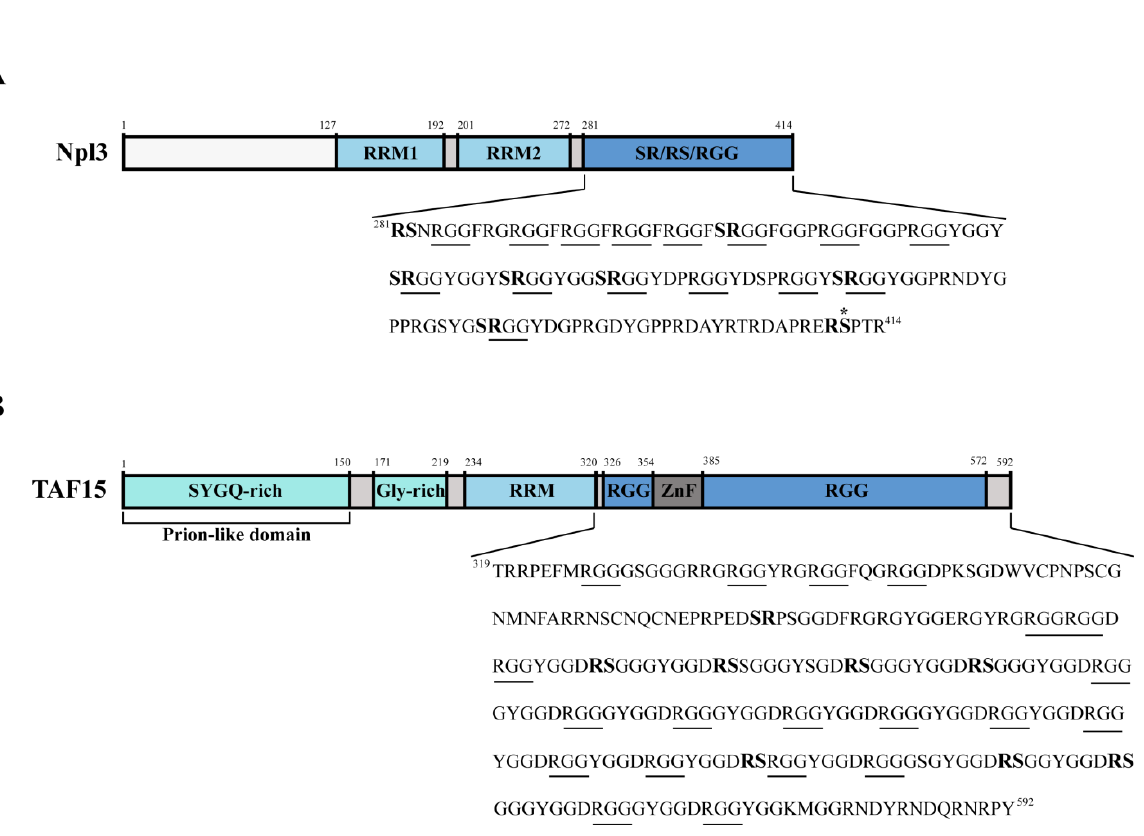
Figure 1. Domain structure and sequence of the RS/RGG domain of S. cerevisiae Npl3 ( A ) and human TAF15 ( B ). RGG repeats and SR/RS dipeptides are underlined and in bold, respectively.